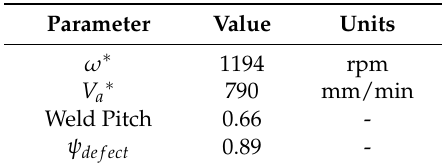
Table 9. Parameters that minimize